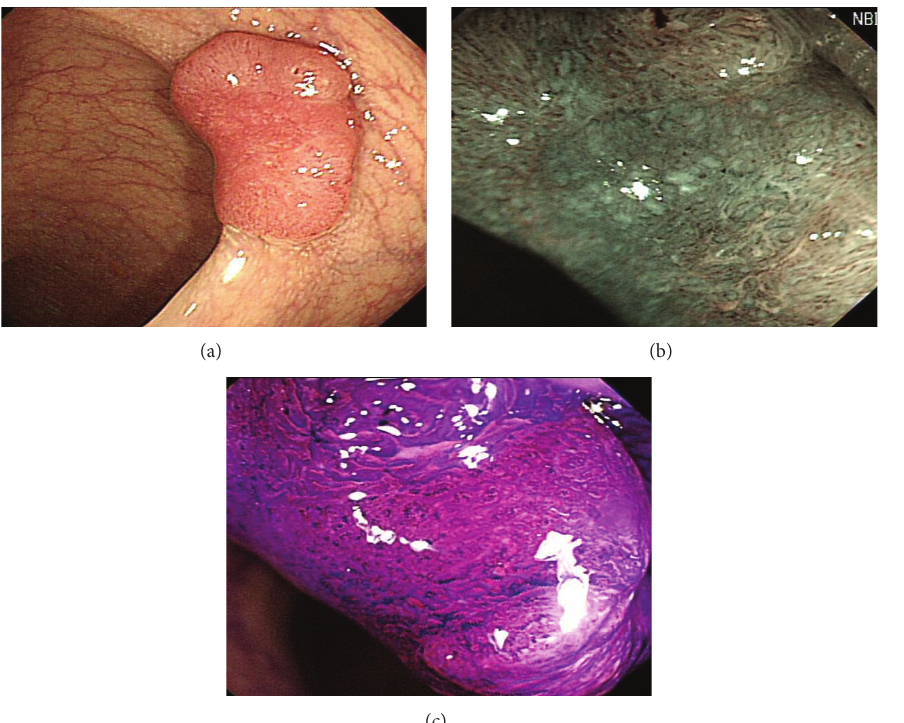
Figure 1: Electronic images of early colorectal cancer. (a) Conventional white-light colonoscopy image. (b) Magnifying narrow-band image. (c) Magnifying chromoendoscopy